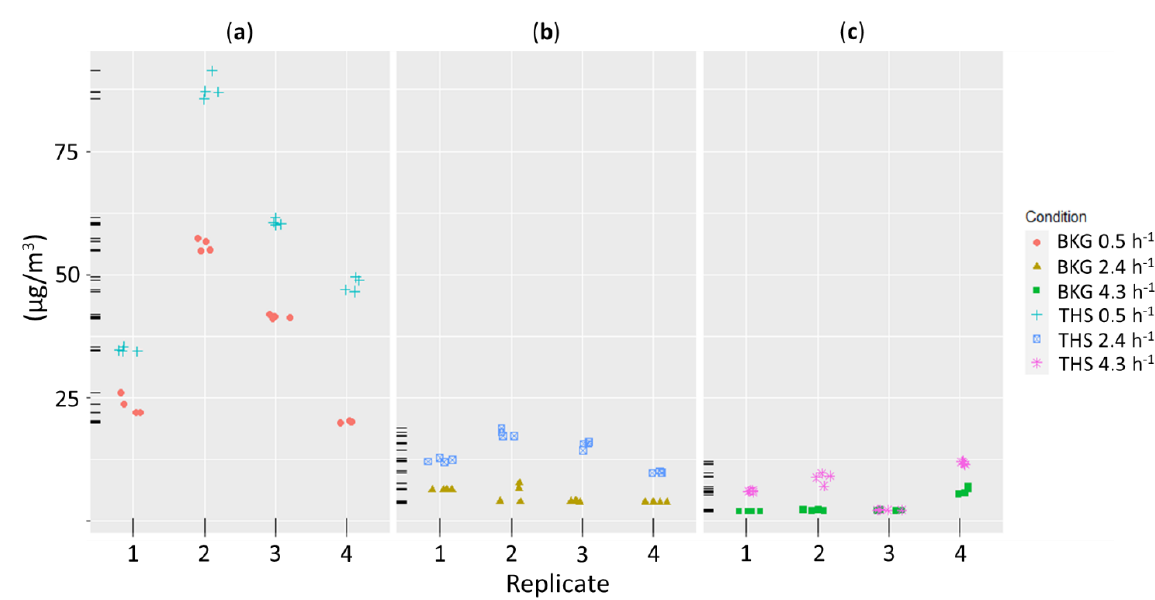
Figure 3. Comparison of the concentrations of airborne glycerin (µg/m 3 ) in the background (BKG) and THS 2.2 use sessions (THS) under simulated ( a ) Residential category III (0.5 h −1 ), ( b ) Store (2.4 h −1 ), and ( c ) Restaurant (4.3 h −1 ) environments.